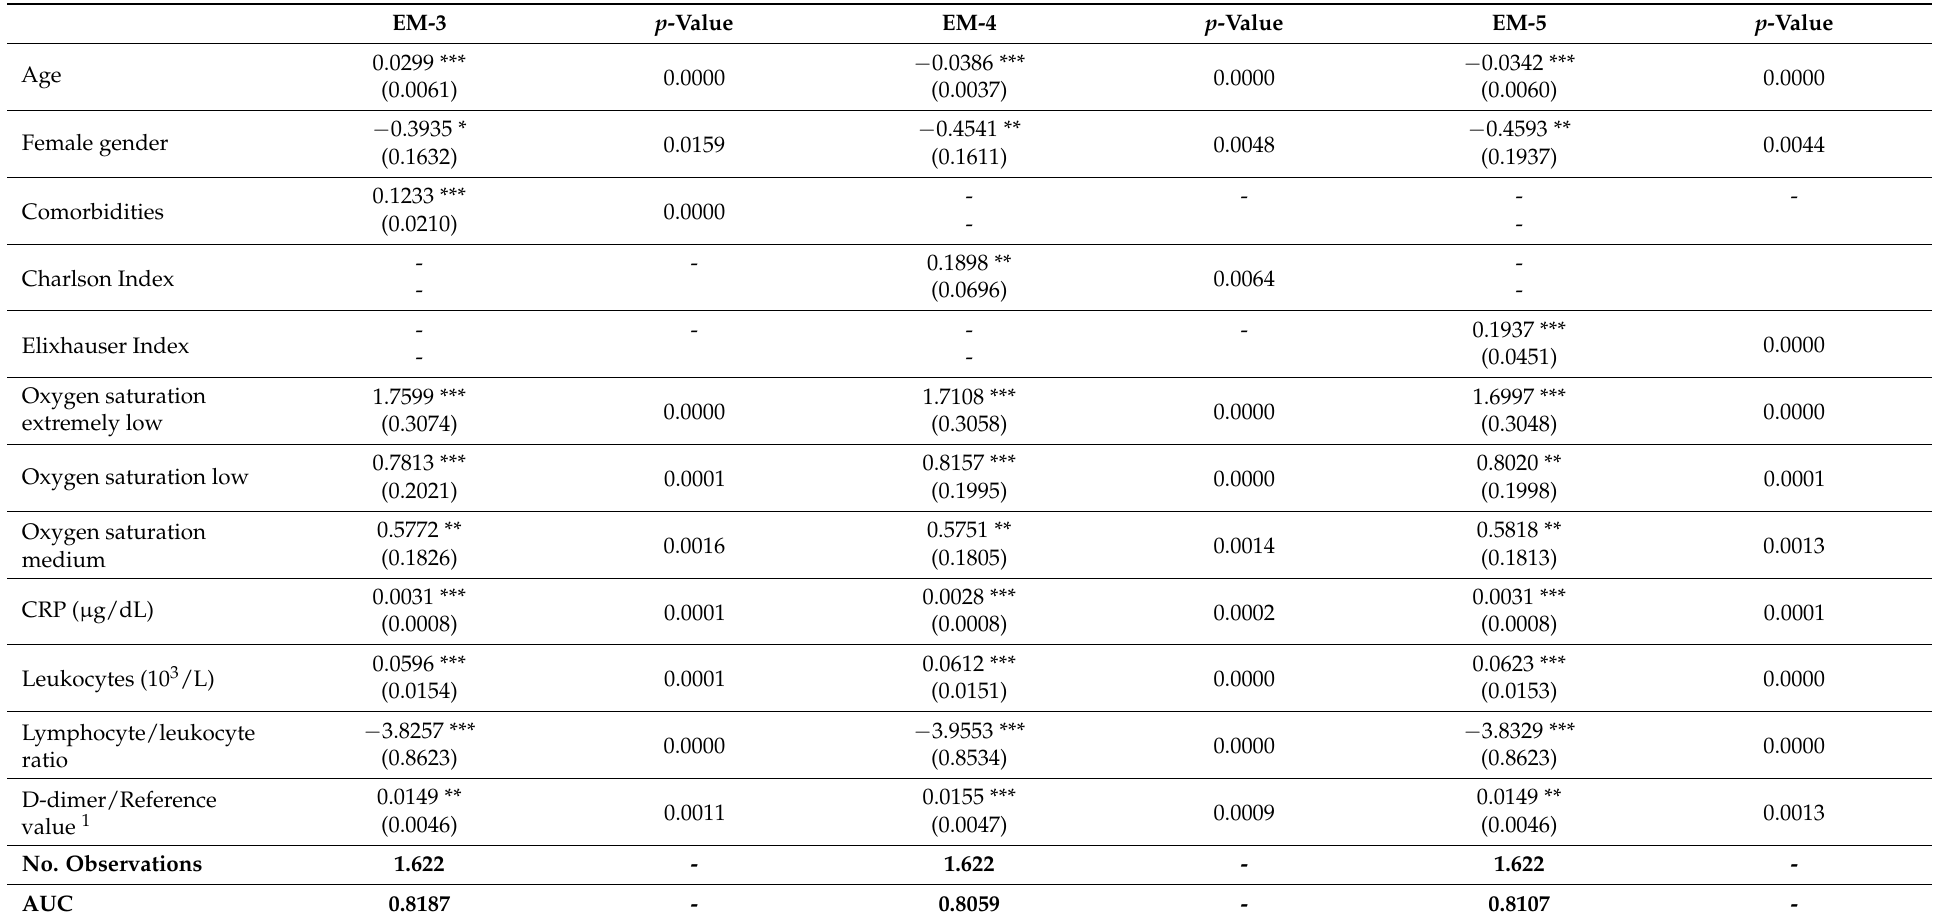
Table 4. Estimated parameters of the models in Grupo Hospitales de Madrid (CH-HM) dataset with alternative specifications for